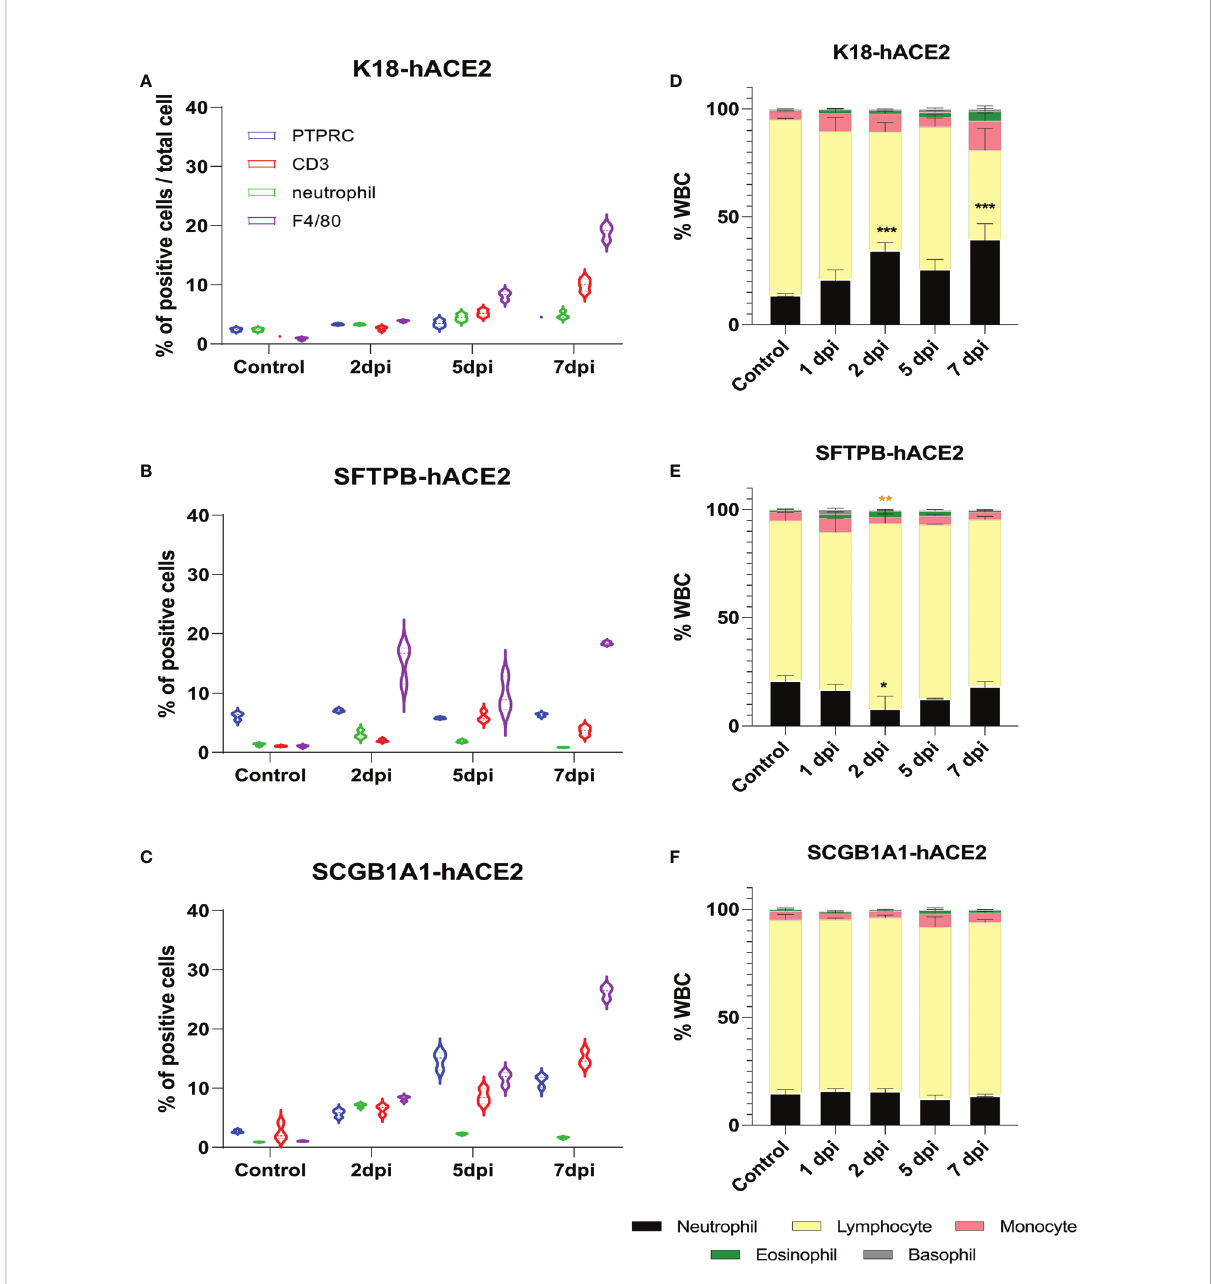
FIGURE 3 Change of immune cell distribution after SARS-CoV-2 infection in the lungs and peripheral blood. (A – C) Summary of the percentage of lung- in fi ltrated immune cells in K18-hACE2 (A) , SFTPB-hACE2 (B) , and SCGB1A1-hACE2 (C) mice. Immunohistochemistry was performed to identify the distribution of immune cells in the lungs with anti-PTPRC, CD3, neutrophil, and F4/80 antibodies at 0, 2, 5, and 7 dpi. DAB-positive cells were counted using QuPath and analysed from three randomly selected images. (D – F) White blood cell counts in K18-hACE2 (D) , SFTPB- hACE2 (E) , and SCGB1A1-hACE2 (F) mice from the peripheral blood at each time point